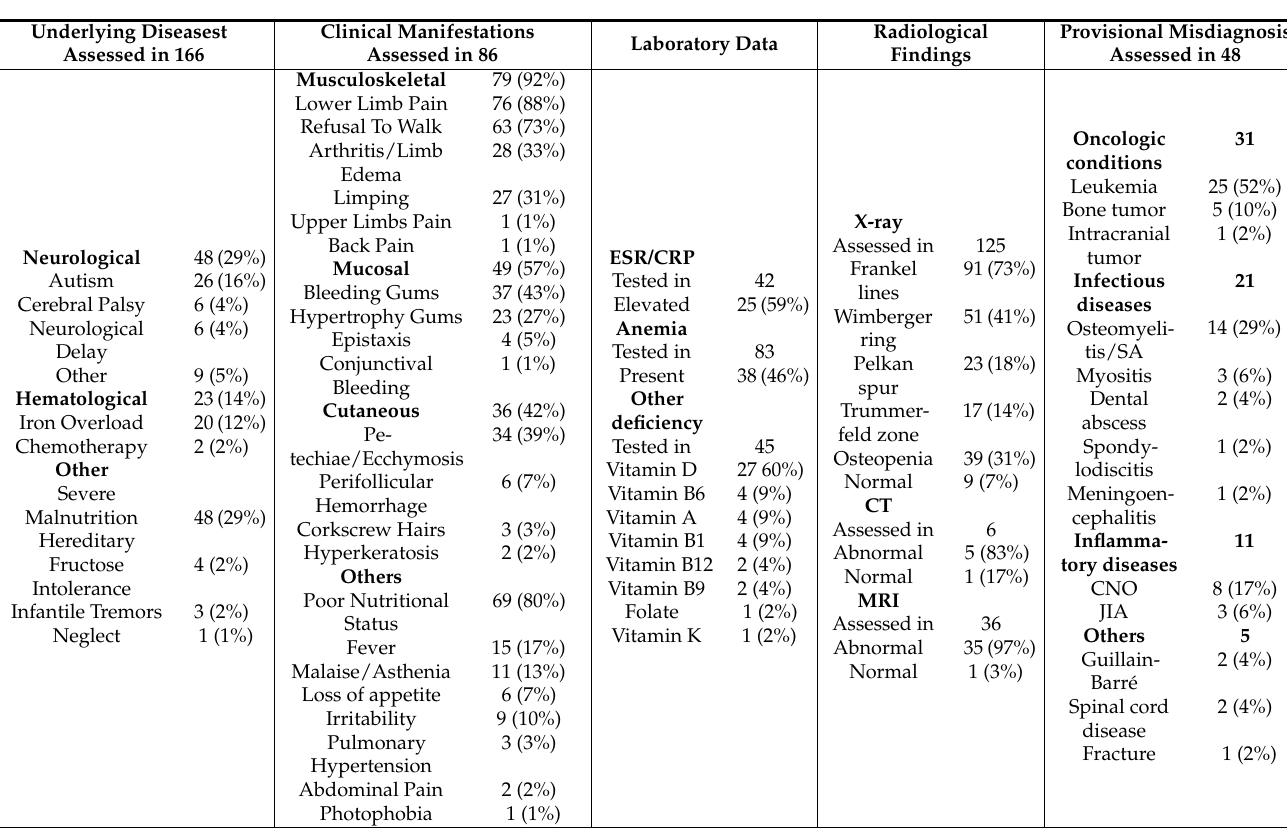
Table 1. Clinical, laboratory and radiological features of the selected 15 studies describing 166 children with